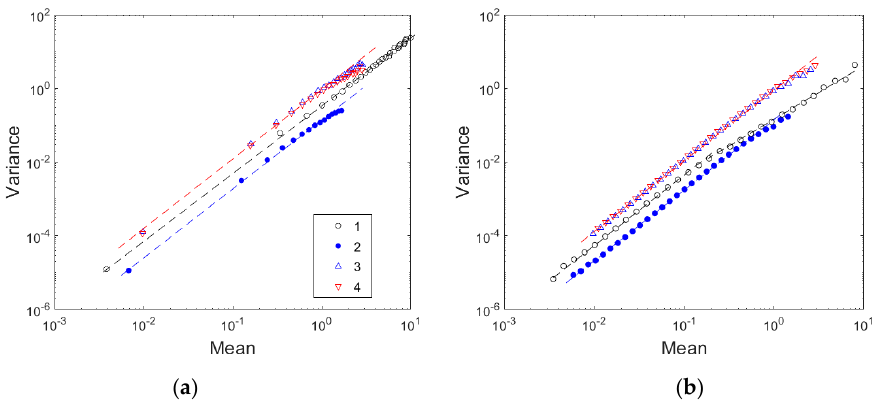
Figure 7. Examples of fluctuation scaling for two specimens. ( a ) Linear bin expansion. ( b ) Logarithmic bin expansion. The designations are unique for both charts: 1—Deformation curve; 2—Large extensometer; 3 and 4—Examples for local extensometers. The units are not shown explicitly and simply correspond to the processed signal. All slope values are close to 1.8 (see the body of the text), except for the large-scale behavior of curve 1 in Figure 7b, corresponding to p = 1.34 ± 0.05.